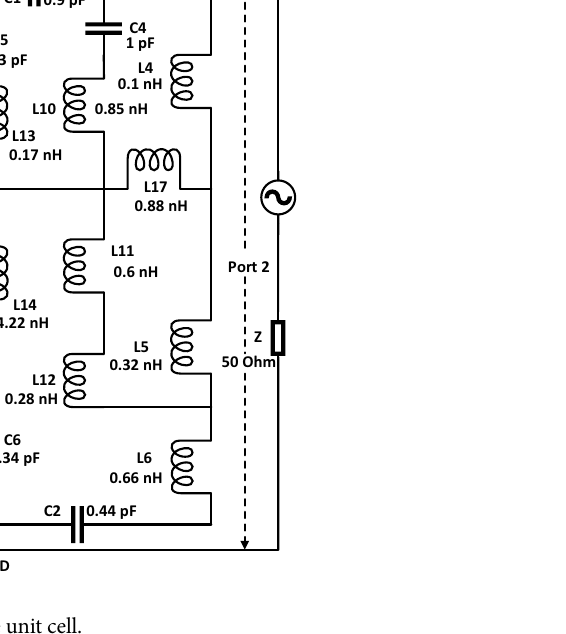
Figure 8. Equivalent circuit of the unit